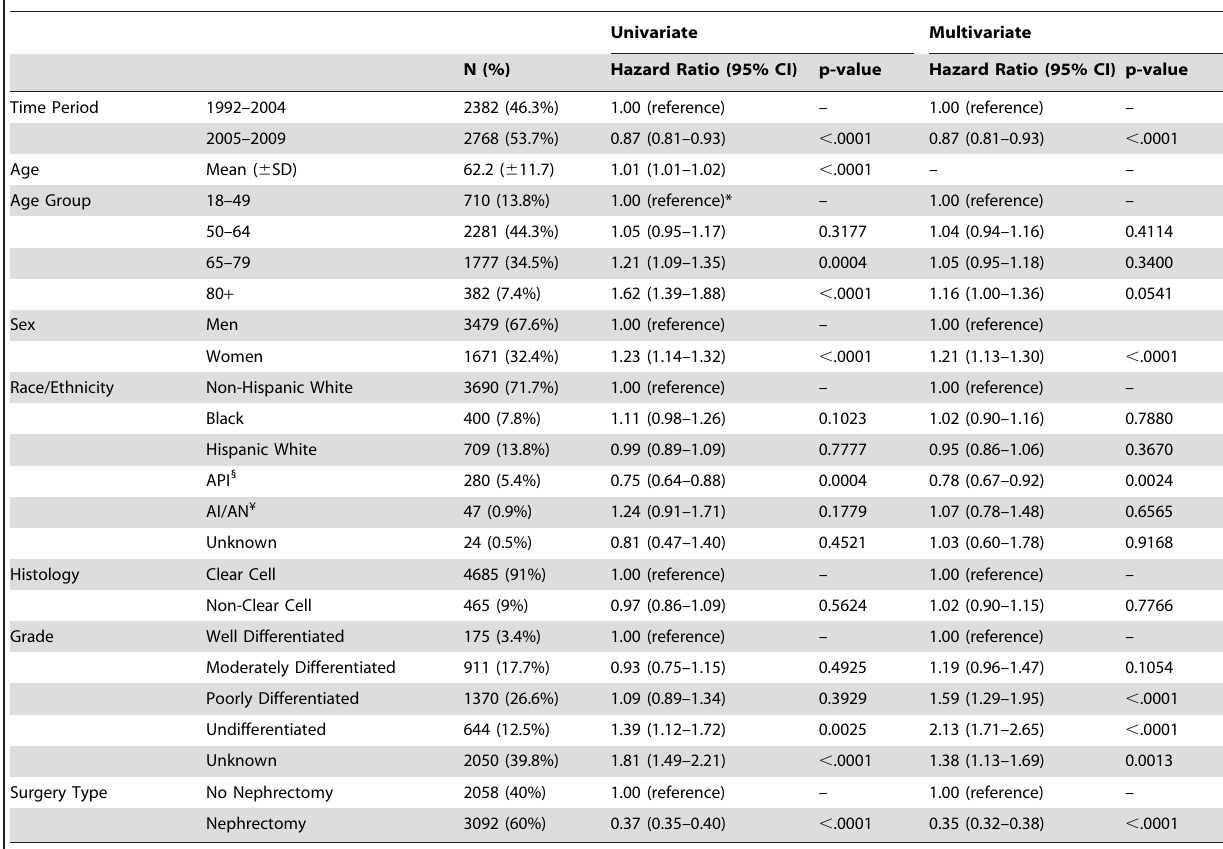
Table 2. Univariate and multivariate analysis of